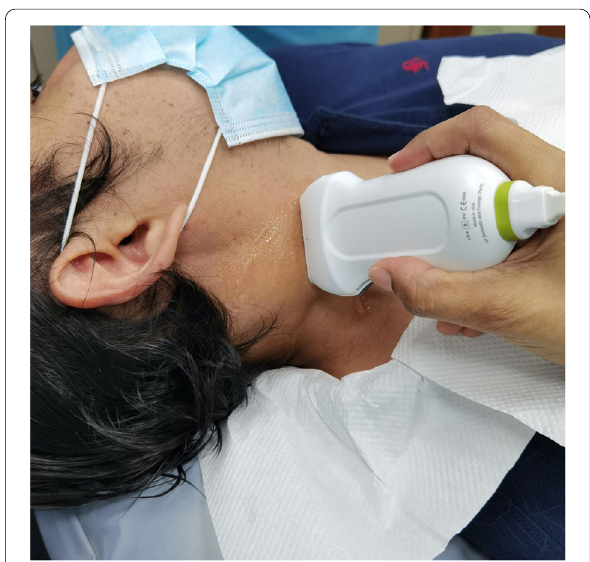
Fig. 1 Surgeon performing USG using portable Philip system high-resolution ultrasound with broadband linear